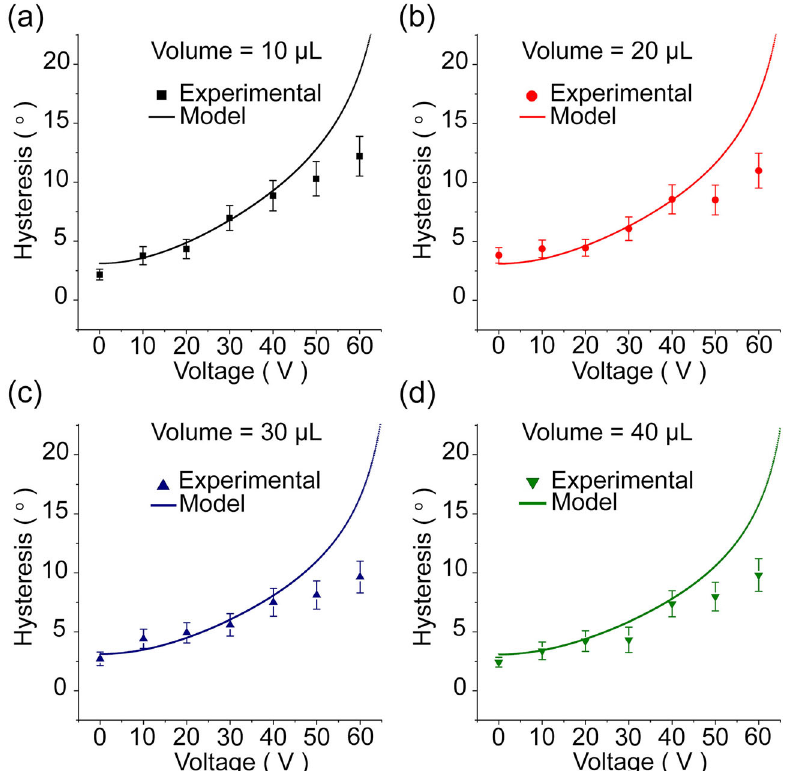
Fig. 3 Voltage-dependent hysteresis for different initial droplet volumes. The initial droplet volumes are a 10 μ L, b 20 μ L, c 30 μ L, and d 40 μ L, respectively. The pitch width of the interdigitated electrodes is 50 μ m. The solid lines were obtained based on our model (Eq. (10)) with contact radii calculated using the Young – Laplace equation (see Supplementary Note 4). Each experimental dot was averaged over 16 independent measurements and the error bars indicate the standard error. Note that the model is only relevant for voltages below contact angle saturation ( ≲ 50